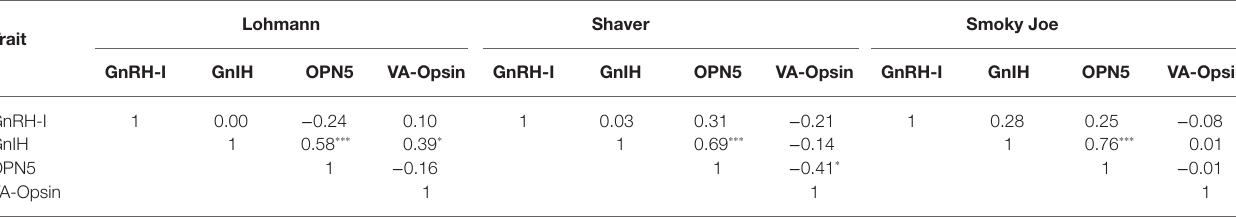
TABLE 5 | Correlations between GnRH-I, GnIH, OPN5, and VA-Opsin in Lohmann, Shaver, and Smoky Joe hens. Lohmann Shaver Smoky Joe Trait